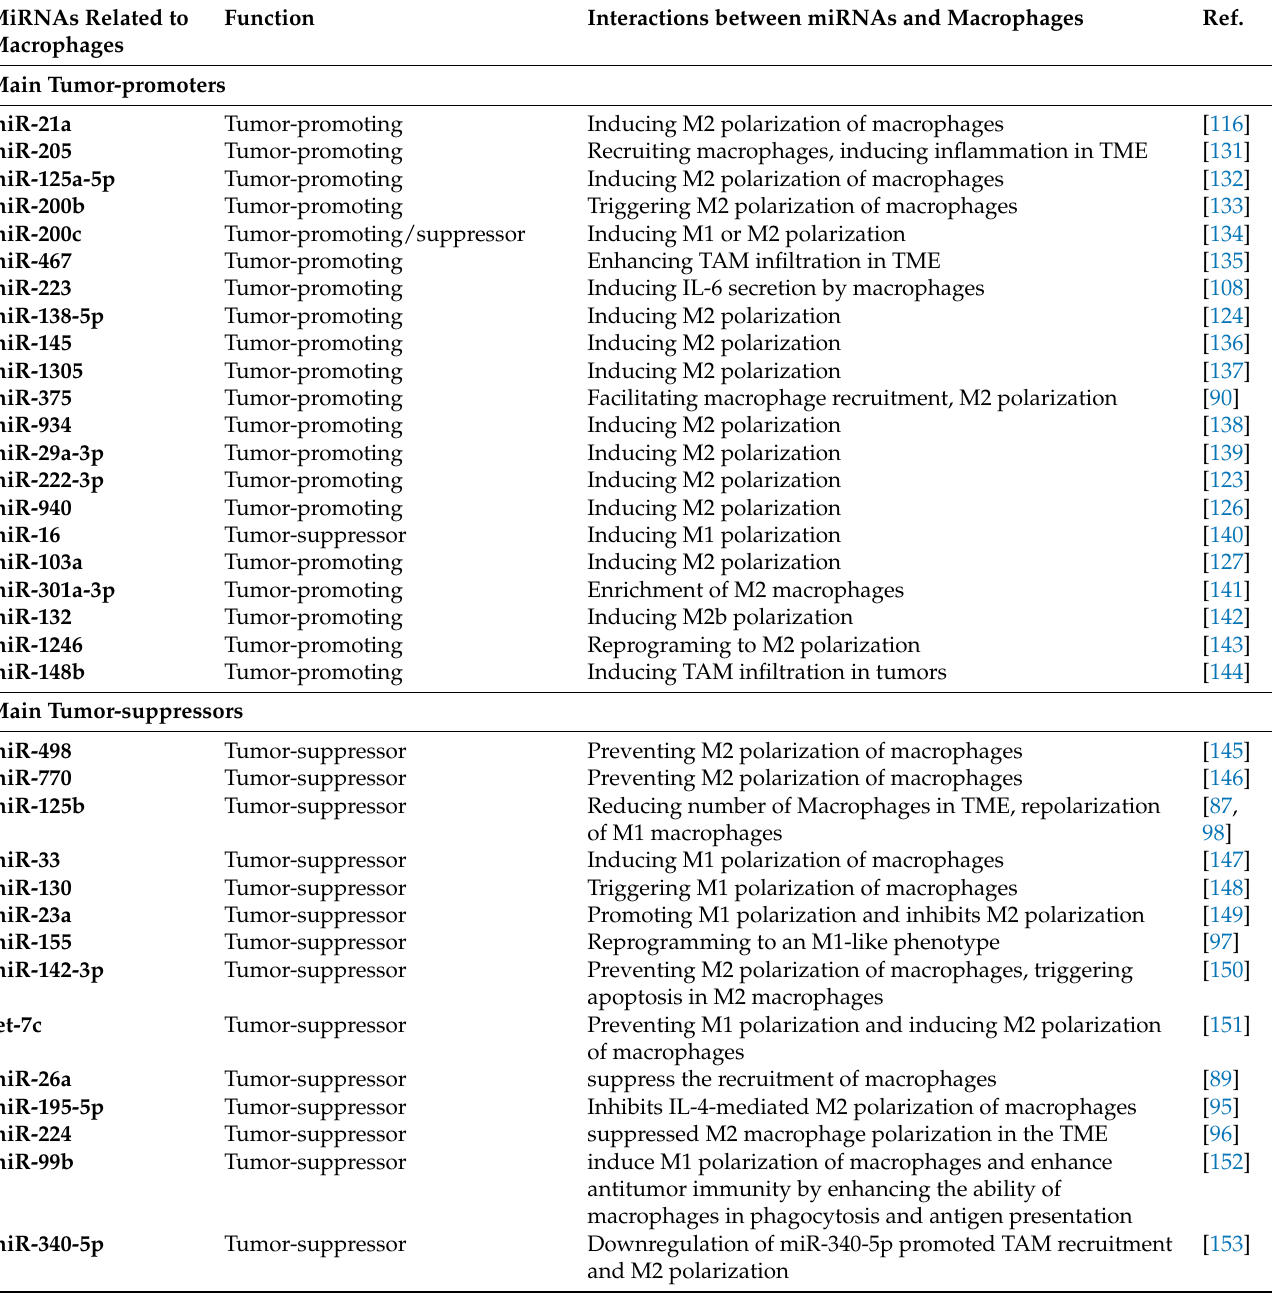
Table 1. Summary of reported MicroRNAs related to tumor-associated